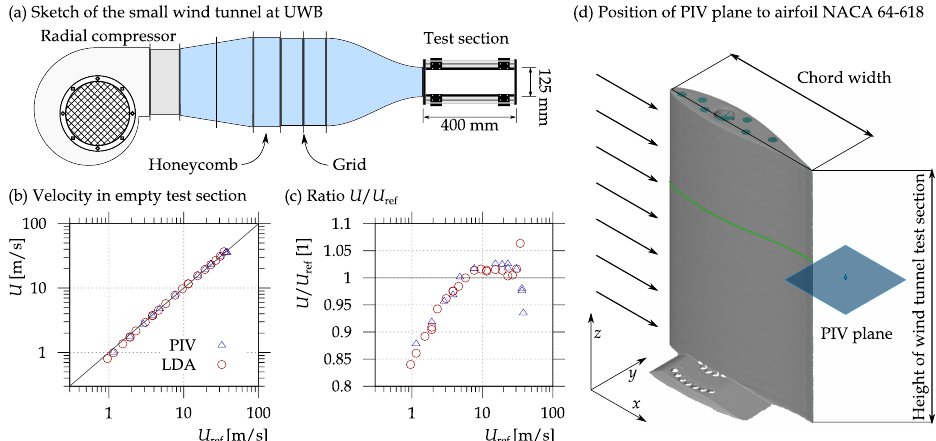
Figure 2. ( a ) Position of the area studied by using Particle Image Velocimetry, depicted as a blue square just behind the trailing edge of the airfoil. The PIV area is a square of side 32mm = 0.4 c . The estimated thickness of the illuminated plane is ∼ 1mm. The laser light comes from the counter-stream direction. ( b – d ) Photograph of the 3D printed realizations of the airfoil. Their trailing parts are blacked in order to suppress the laser reflections.